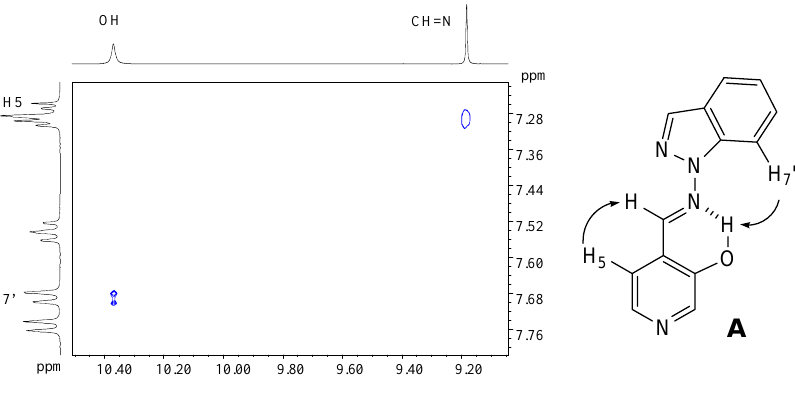
Figure 4 . NOESY spectrum of compound 7b in CDCl